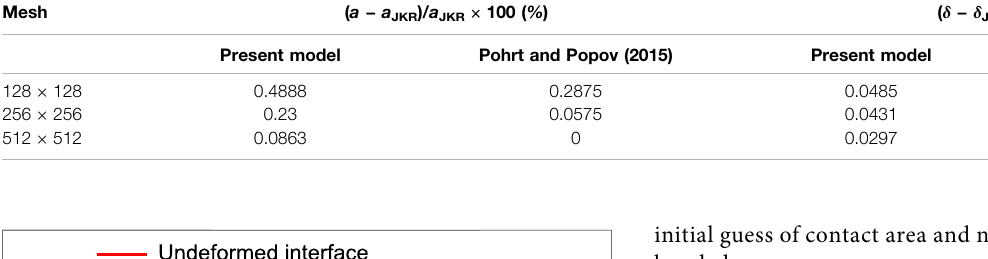
TABLE 3 | Resultsof mesh convergence test of the presentand previous BEM models. All key parameters are the same as that give in the caption of Figure 6 . Normal load F (cid:1) 5| F min |. a JKR (cid:1) 0.3478 (mm) and δ JKR (cid:1) 7.4188 × 10 – 3 (mm) are solutions of JKR theory. Mesh